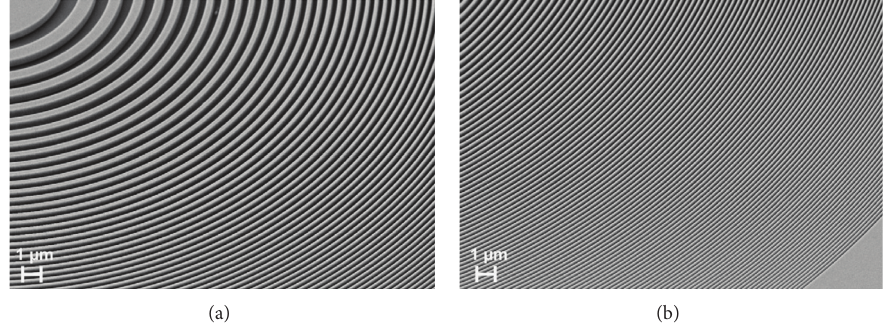
Figure 6: SEM images of sections of a 100 𝜇 m diameter Fresnel zone plate made of gold and patterned by IBL. The outermost ring is approximately 100nm wide and has a 5: 1 aspect ratio. This plate was tested and shown to provide 100nm imaging resolution when used with 1200 eV X-rays. Reprinted from [135].